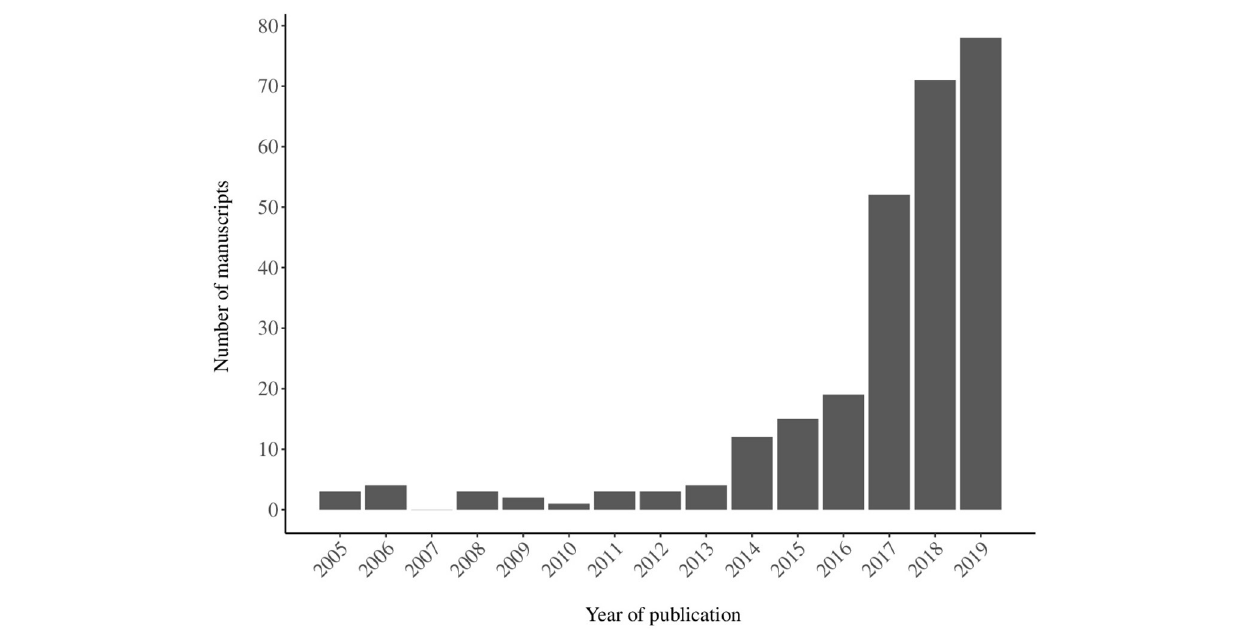
FIGURE 2 | The number of self-identified planetary health manuscripts published by year based on 270 articles included in scoping review.